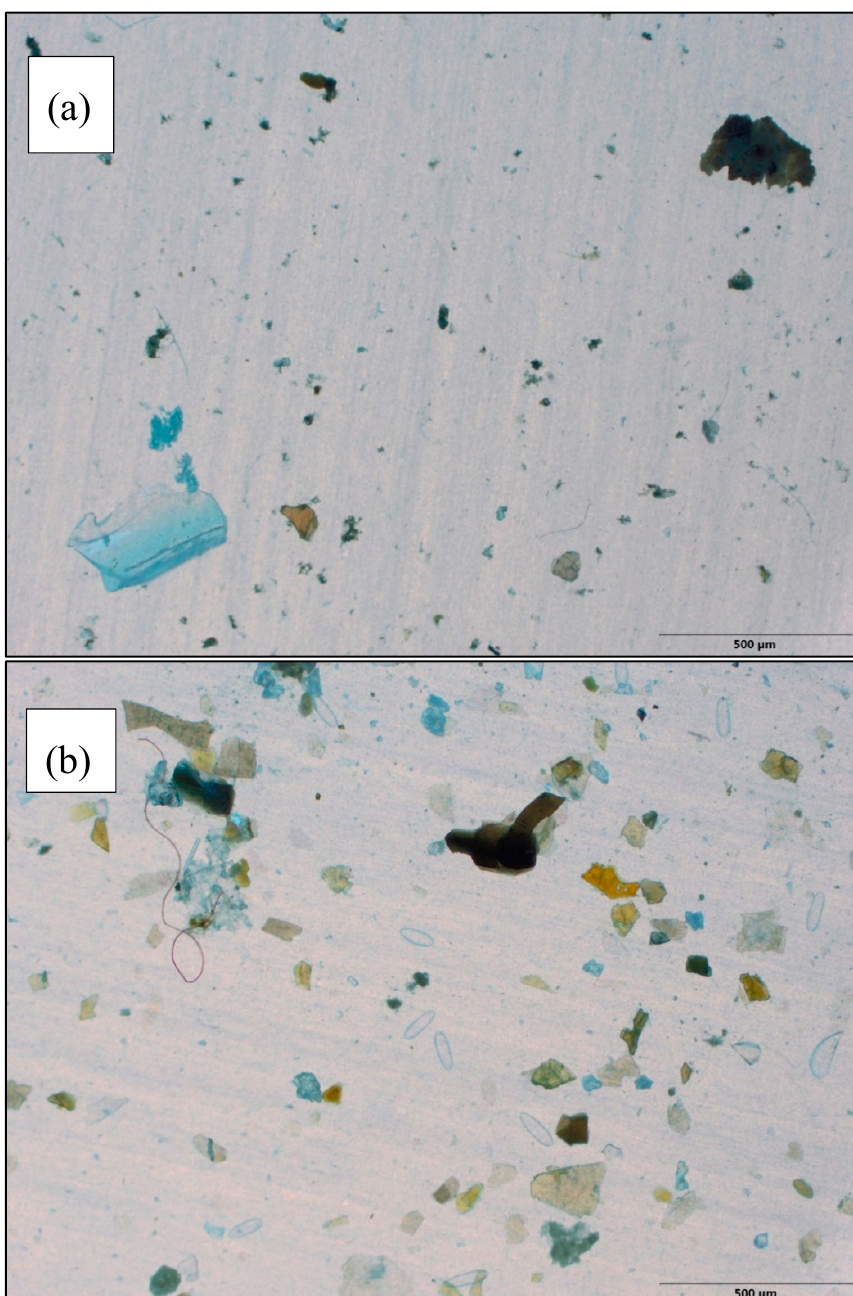
Figure 4. ( a ) Particles deposited on Al 2 O 3 filters, observed by optical microscopy in the sample of the lake water column (H) and ( b ) in the sample of the outlet of the lake (O).